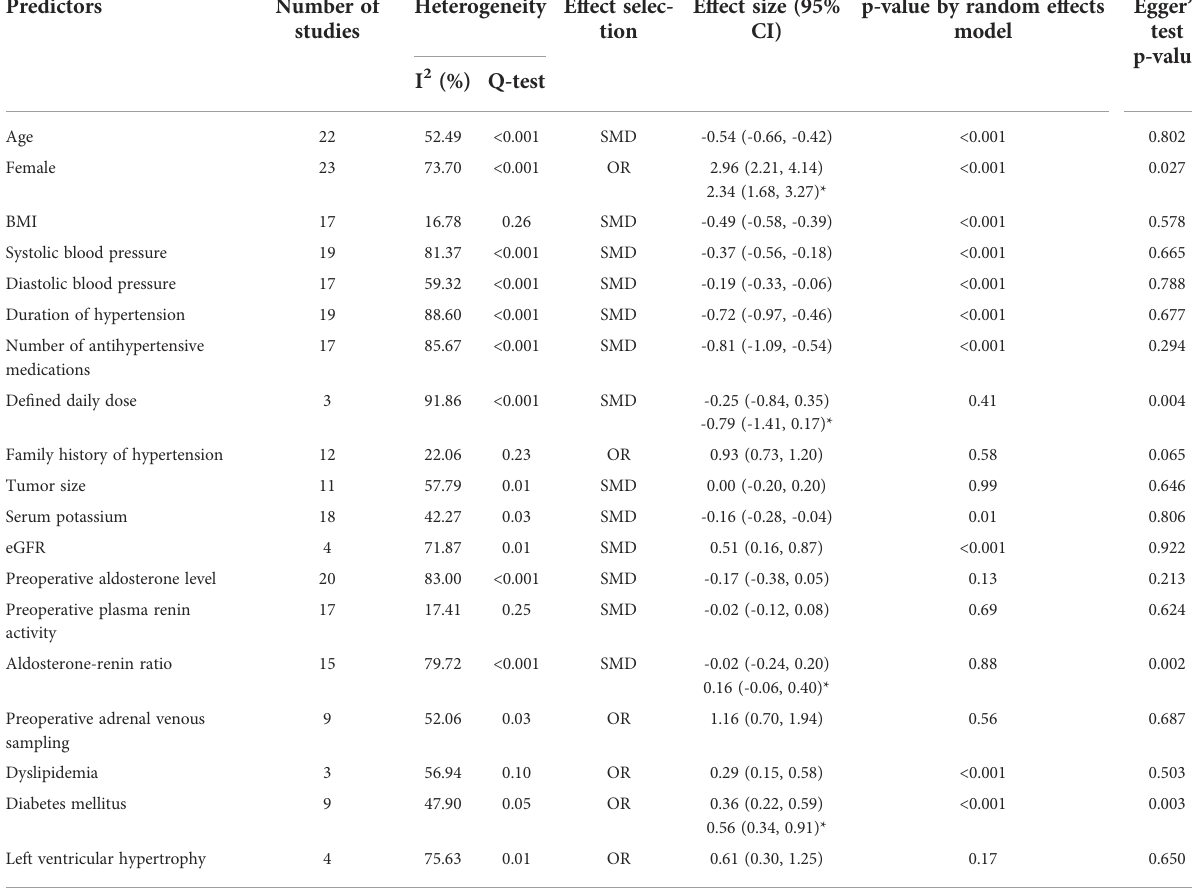
TABLE 5 Meta-analysis of predictive factors of clinical success after adrenalectomy in primary aldosteronism using crude data.